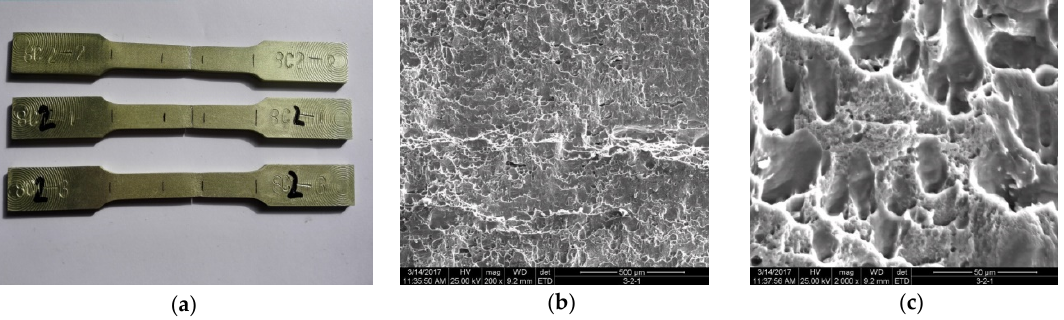
Figure 7. Fracture of the specimens: ( a ) mechanical testing of the weld joints; ( b ) fracture surface of tension specimen; ( c ) fracture surface of tension specimen.